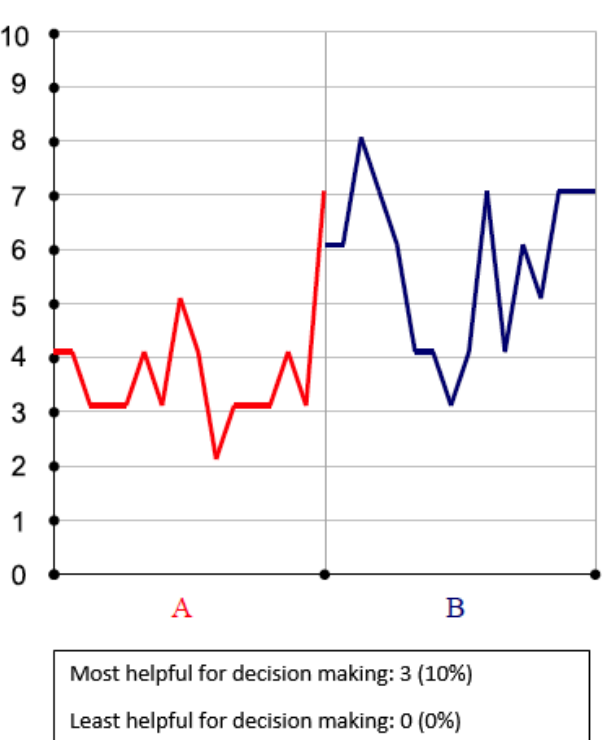
Figure 3. Pain intensity by treatment (zero is no